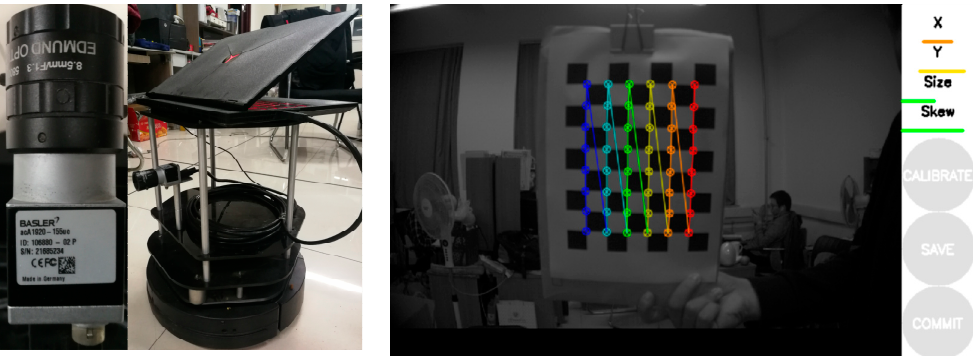
Figure 16. The camera and notebook were installed on the mobile ground equipment. Then, the camera was calibrated using a checkerboard to eliminate radial distortion.